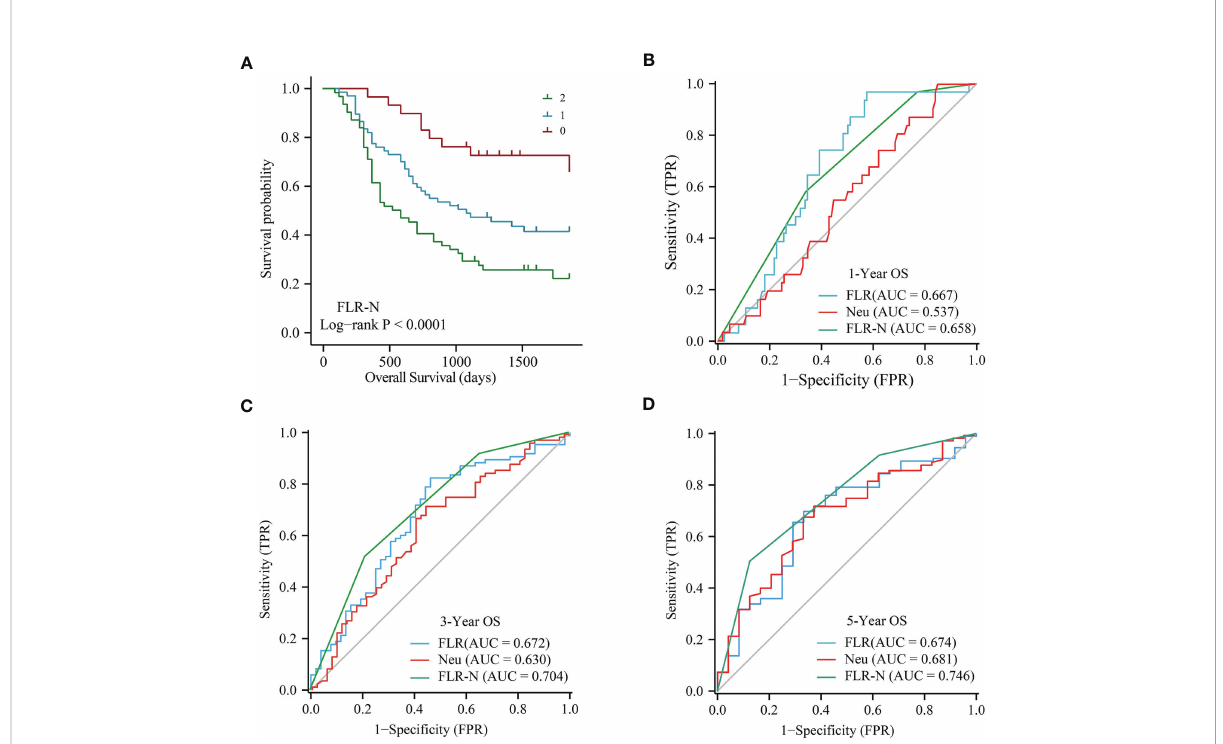
FIGURE 4 Predictive power of FLR-N for patients with resectable ECC. (A) Kaplan − Meier curves for OS based on FLR-N. B, ROC curve analyses of FLR, neutrophils, and FLR-N for 1-year (B) , 3-year (C) , and 5-year (D) OS in patients with resectable ECC. ROC, receiver operating characteristic; AUC, area under the ROC curve; OS, overall survival; FLR, fi brinogen-to-lymphocyte ratio; FLR-N, FLR +